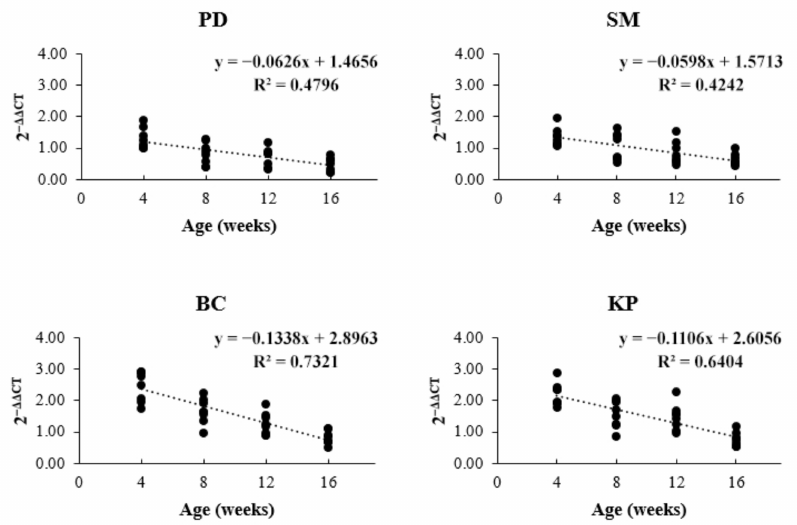
Figure 4. Trend of expression level of CARNS1 with increasing age. PD = Pradu Hang Dam breed (Thai native chicken); SM = Sri Mok breed (crossbred between BC and PD); BC = Black-Chinese breed (black-bone chicken); KP = KU-Phuparn breed (black-bone chicken). A significant negative linearity was observed in this study ( p < 0.0001).